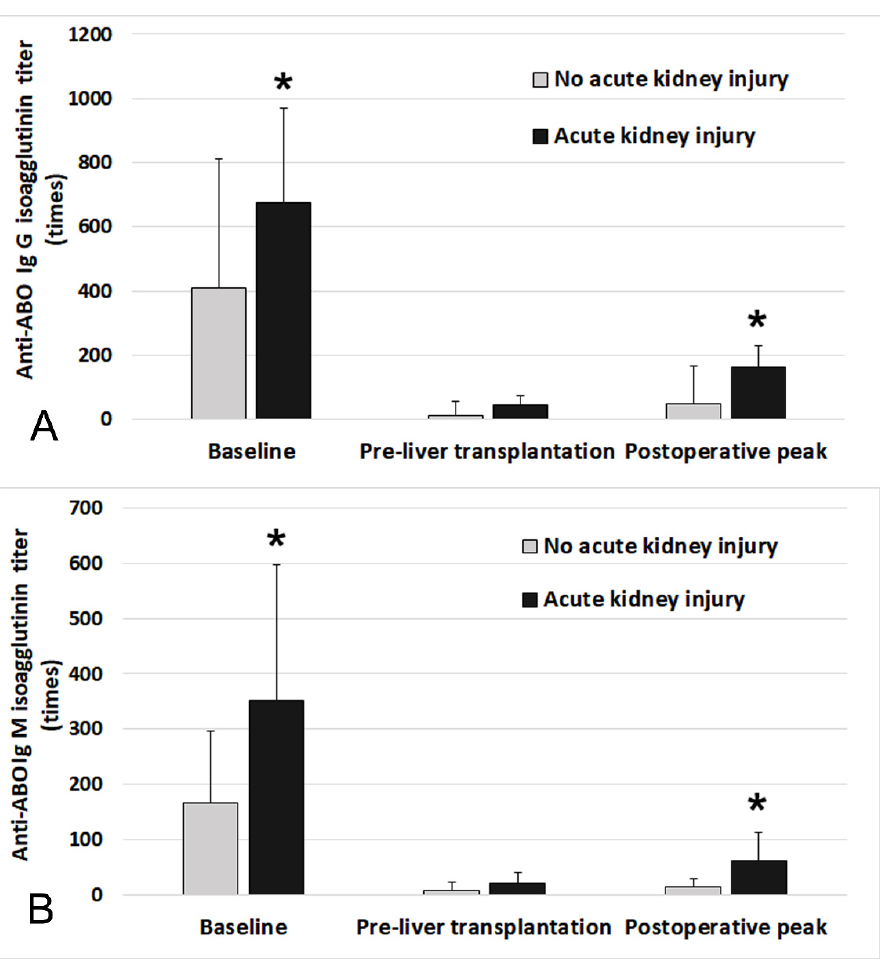
Figure 2. Anti-ABO blood type Ig G ( A ) and Ig M ( B ) isoagglutinin titers at baseline, pre-liver transplantation, and postoperative peak between patients with and without postoperative acute kidney injury. Pre-liver transplantation refers to the titer measured before the day of transplantation and postoperative peak titer was determined as the highest value during the postoperative two weeks. * Significant difference between groups ( p < 0.05). Ig = immunoglobulin. The top edge of each box shows the mean value and the error bar shows standard deviation.